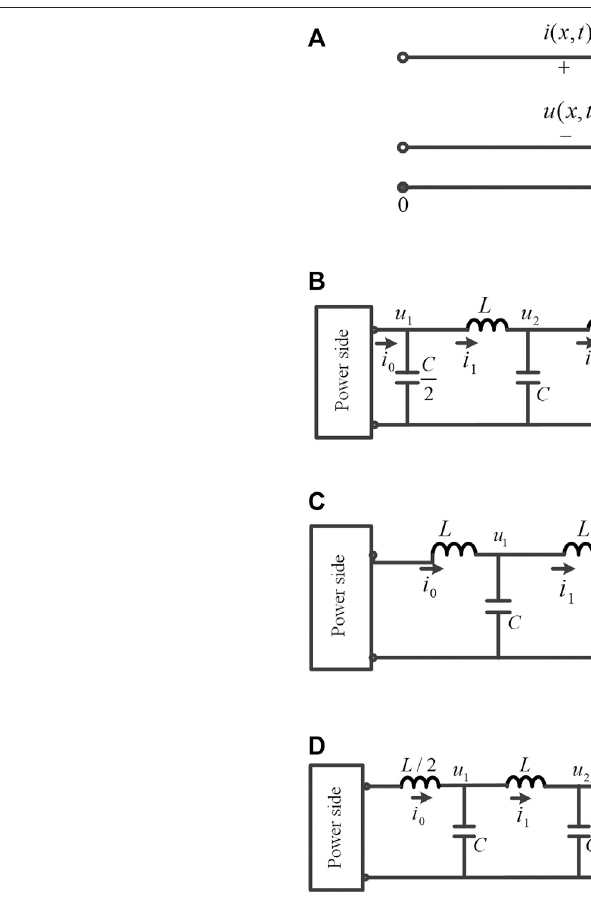
Frontiers in Energy Research |